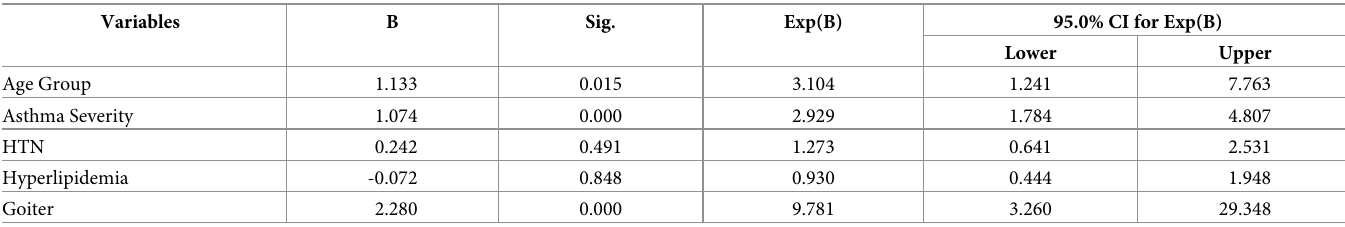
Table 4. Multivariate analysis using Cox-Model of the significant variables identified from the univariate analysis of the asthmatic cohort with and without cancer. Variables B Sig.